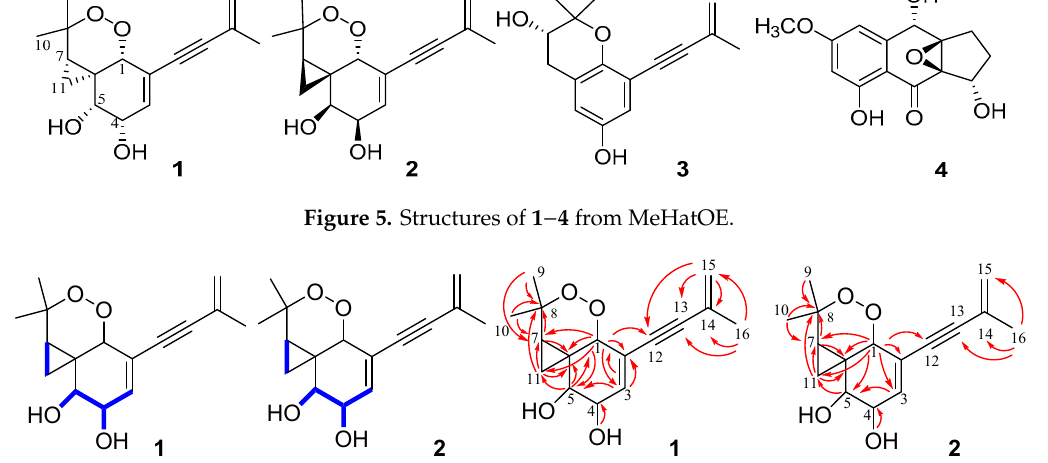
Figure 5. Structures of 1 − 4 from MeHatOE.